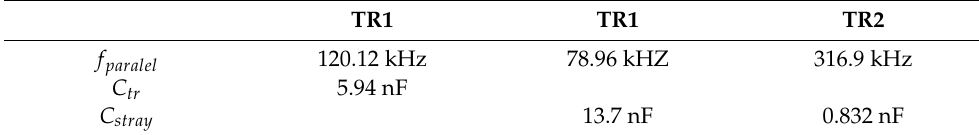
Table 3. Frequency response measurements for prototypes.